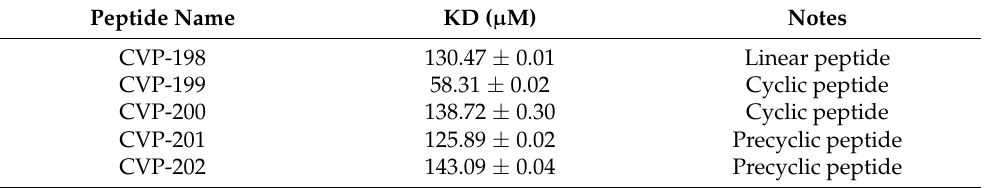
Figure 6. Binding curves for the interactions between linear, precyclic, and backbone cyclic pep- tidomimetics and the TcPink1 protein. The Y-axis corresponds to the I-Response in biosensor units (BU), and the X-axis corresponds to the different concentrations of the analyte in the experiment. The data was normalized and presented as the fraction of bound peptide. A control study was also performed in which the biomolecular interaction between TcPink1 and a control peptide, TAT, was done. It is evidenced that there is very low interaction between TcPink1 and the control peptide, TAT. Table 2. Summary of the corresponding in vitro K D values of the peptides binding to